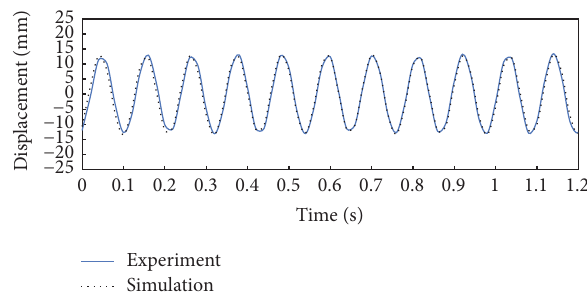
Figure4:Displacementsoftheoffshoreplatformwiththebufferable TMD under sinusoidal excitation.